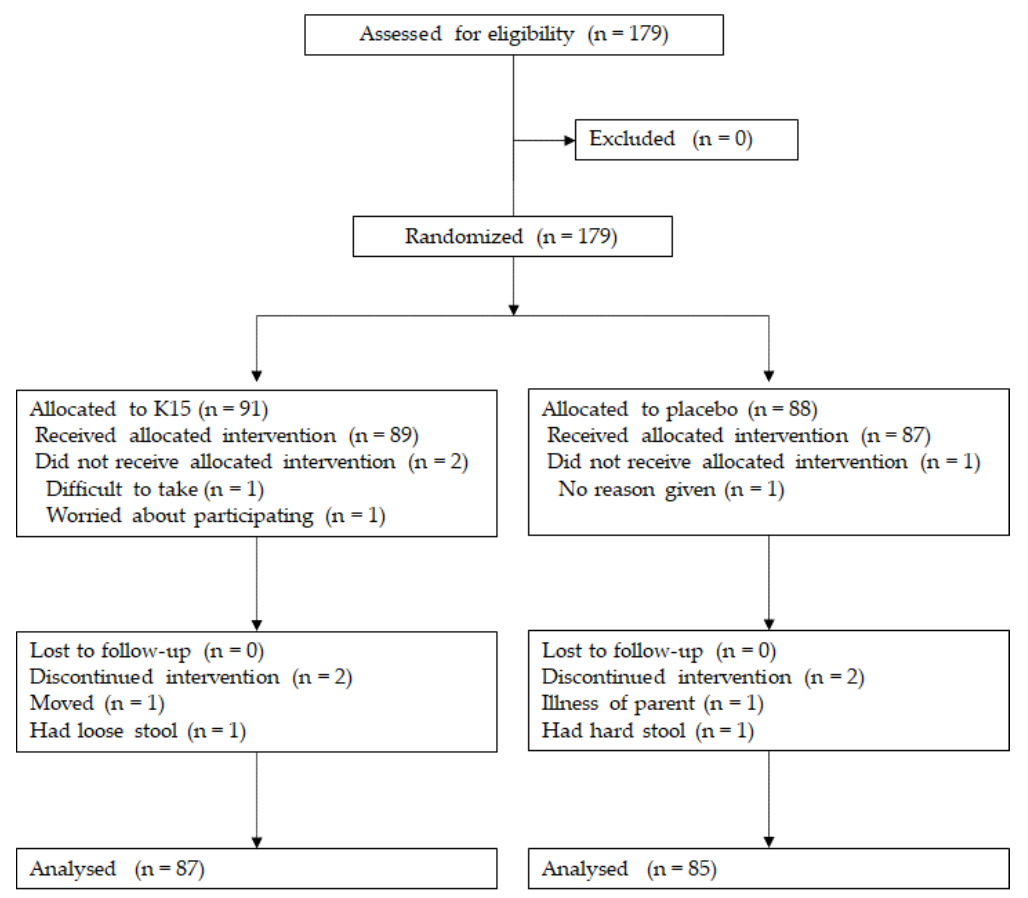
Figure 1. Flowchart of the study recruitment. Table 1. Baseline characteristics.